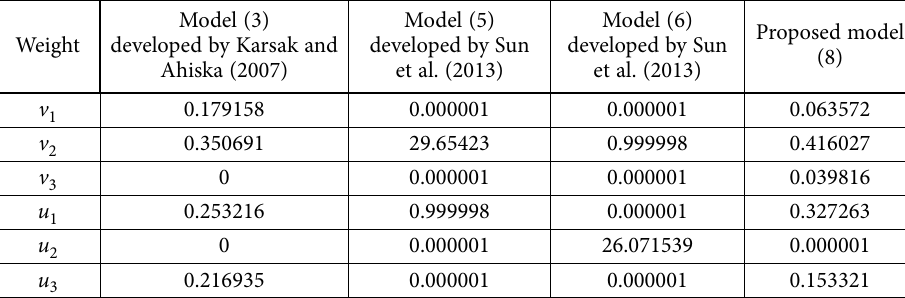
Table 8. Comparative evaluation of input and output weights Model (3) Weight developed by Karsak